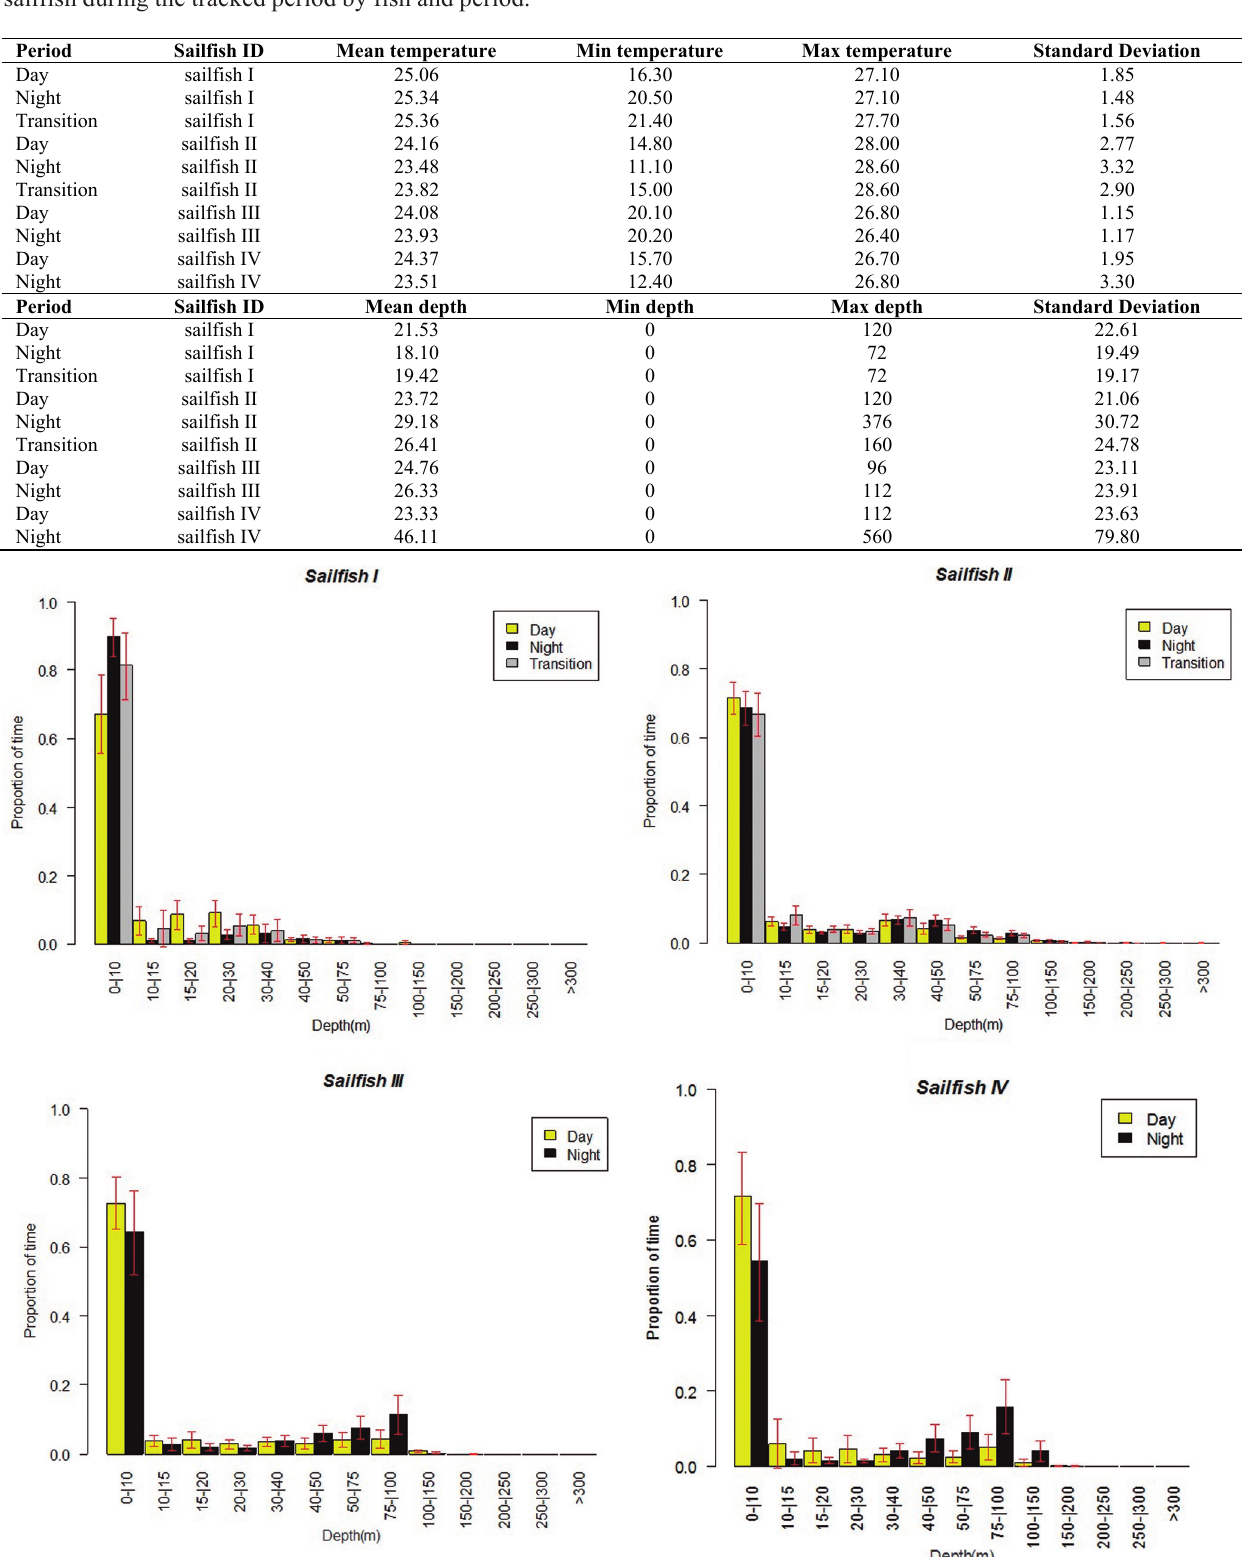
Fig. 1. Depth histograms, showing relative frequency of time spent at depth for each tagged sailfish. Error bars indicates the standard errors around mean